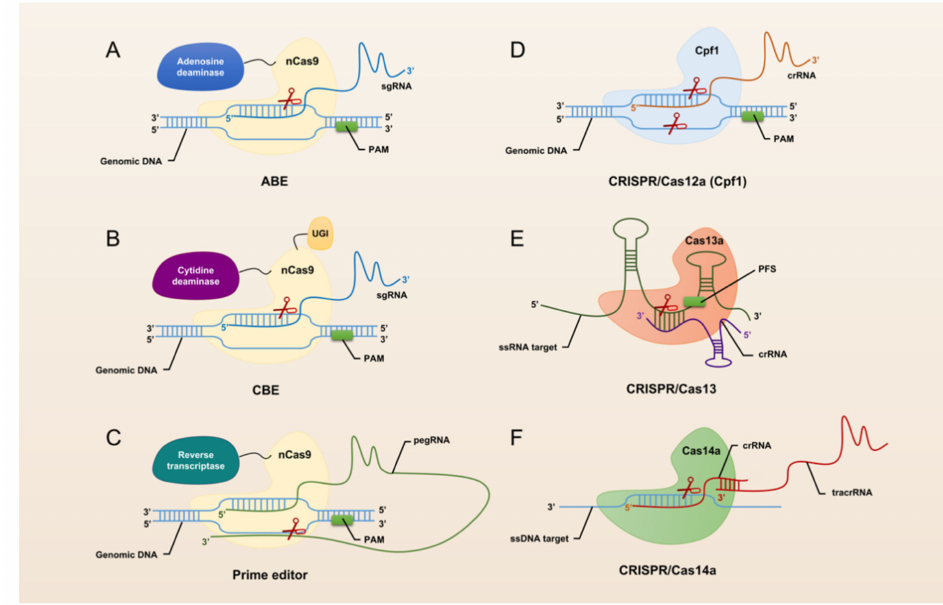
Figure 2. Schematic summary of CRISPR/Cas systems used for genome